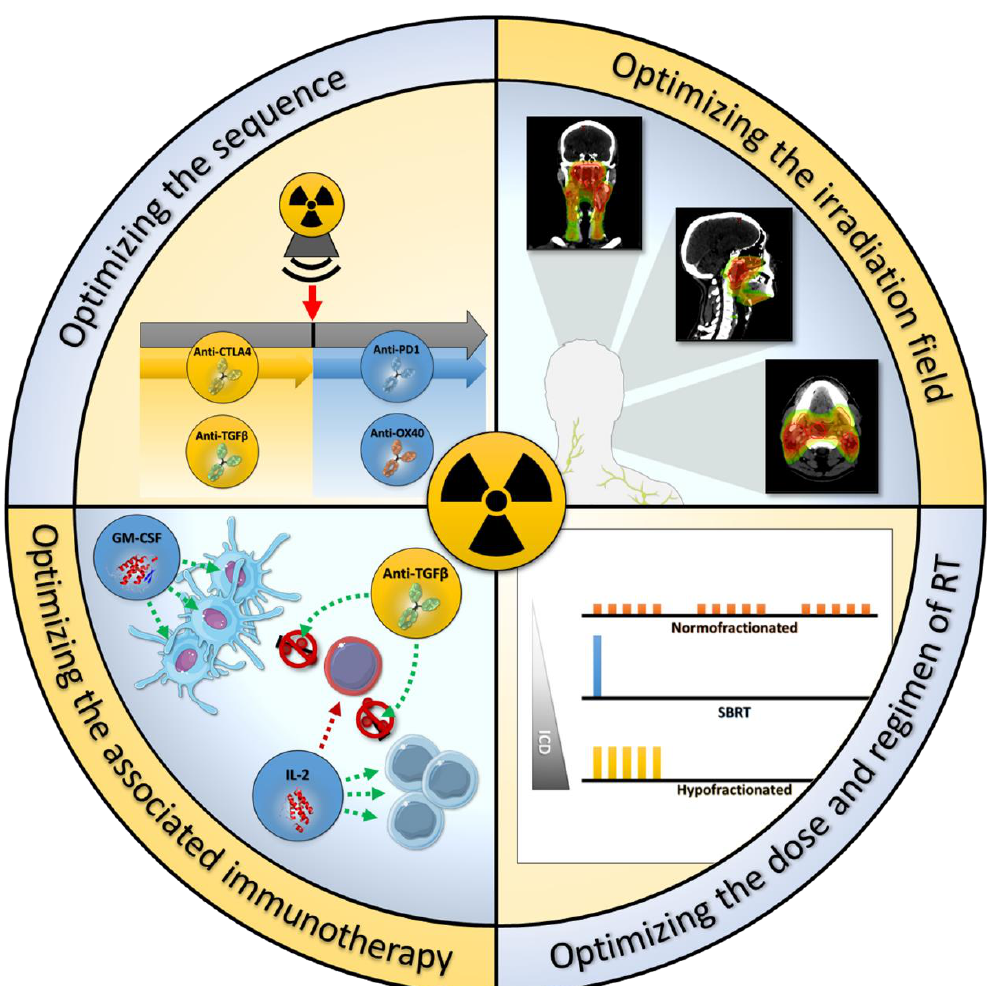
Figure 2. The different possible optimizations of RT to improve its immune effects. The optimisation of RT immune effects could be summarized in four categories: (i) optimizing the sequence, (ii) optimizing the associated immunotherapy, (iii) optimizing the dose per fraction and RT regimen, (iv) optimizing the irradition field. CTLA4, cytotoxic T-lymphocyte- associated protein 4; GM-CSF, granulocyte-macrophage colony-stimulating factor; IL-2, interleukin 2; PD1, programmed cell death protein 1; SBRT, stereotaxique body radiation therapy; TGFβ, transforming growth factor beta. This figure was created using Servier Medical Art templates (Creative Common Attribution 3.0), https://smart.servier.com (access on 29